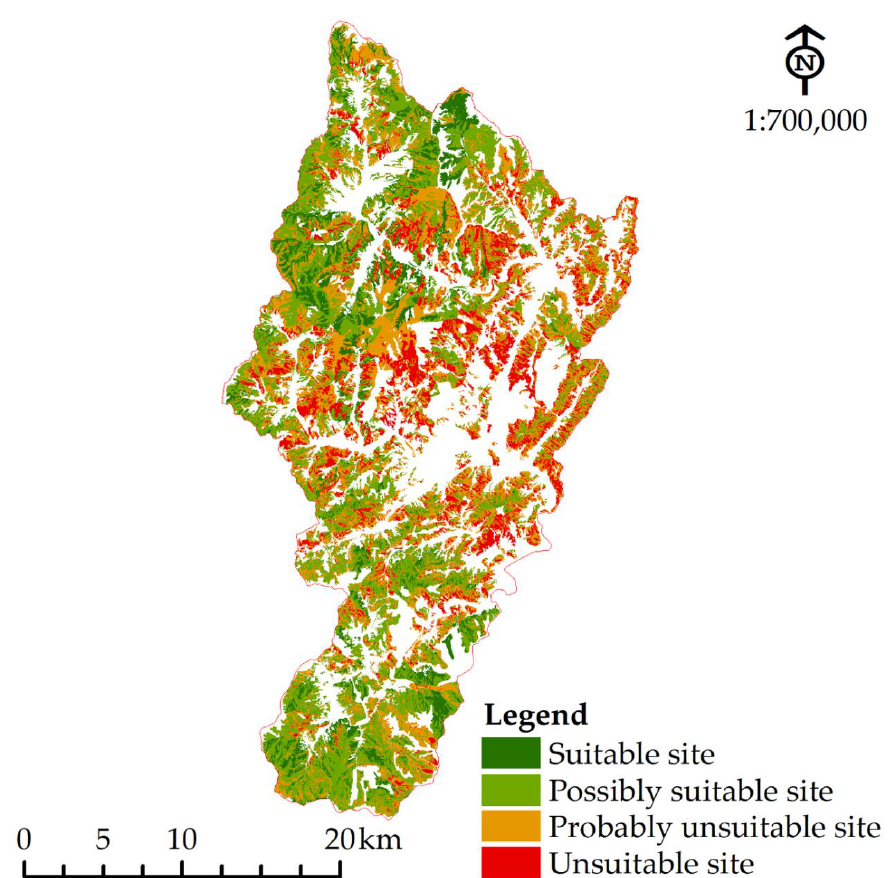
Figure 7. Map of the identification results of suitable WSG cultivation sites in Hamyang-gun forests. Note: Dark green color = suitable site (4756 ha), green color = possibly suitable site (17,941 ha), orange color = probably unsuitable site (16,352 ha), and red color = unsuitable site (7501 ha).